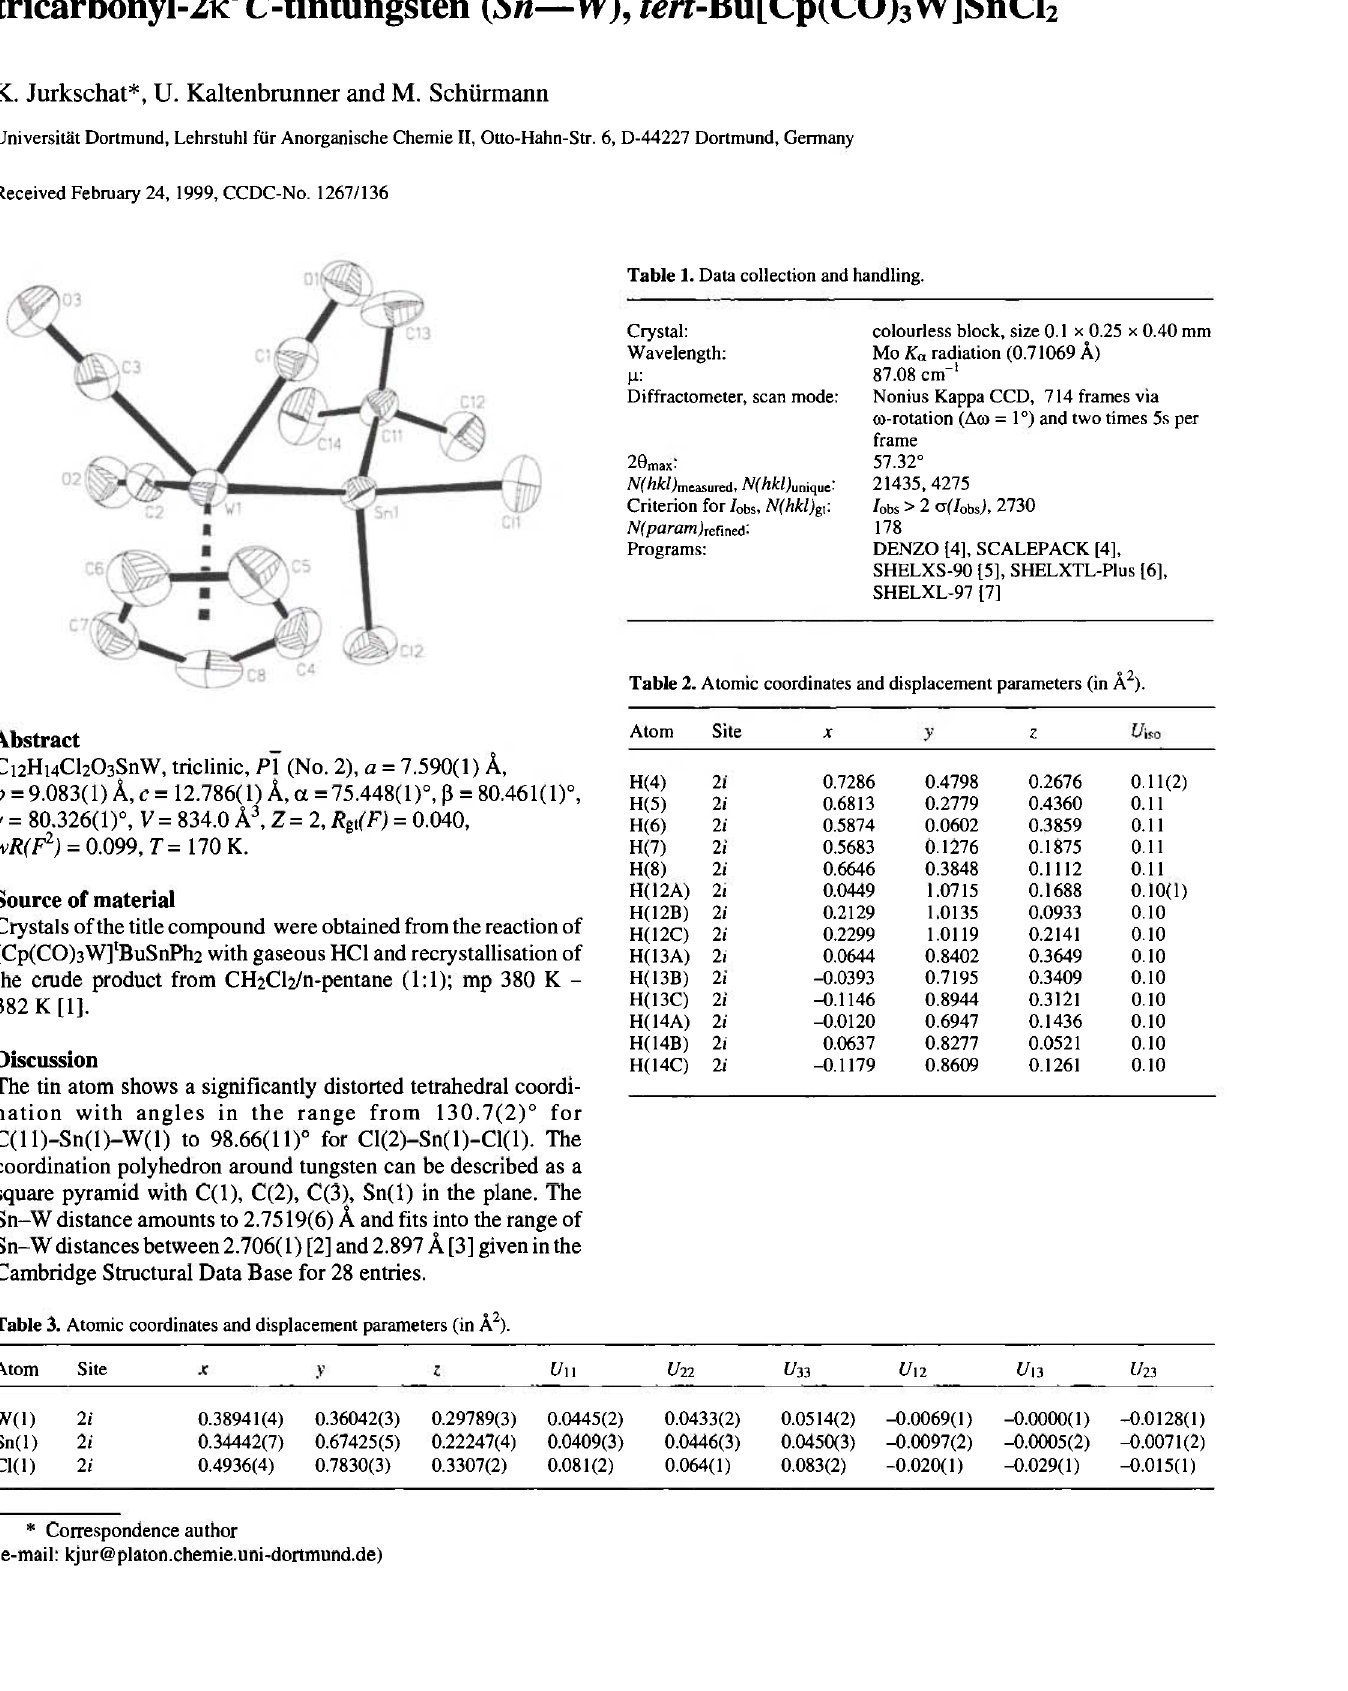
Table 1. Data collection and handling.